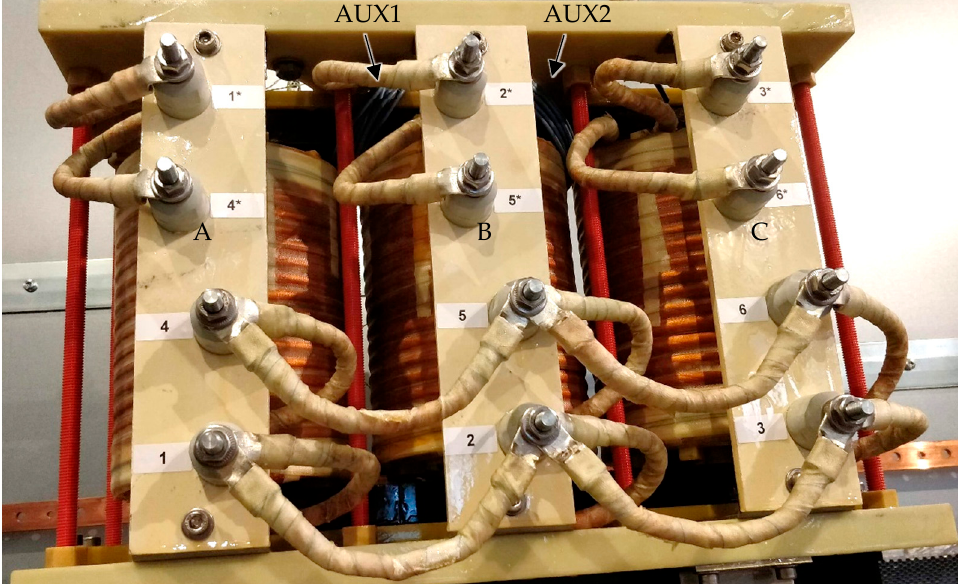
Figure 2. Medium frequency transformer prototype T2 showing primary winding terminals: 1*-1, 2*-2, 3*-3, secondary winding terminals: 4*-4, 5*-5, 6*-6, three columns A, B, C, and additional auxiliary coils AUX1 and AUX2 for flux measurement (blue wire around the yoke).